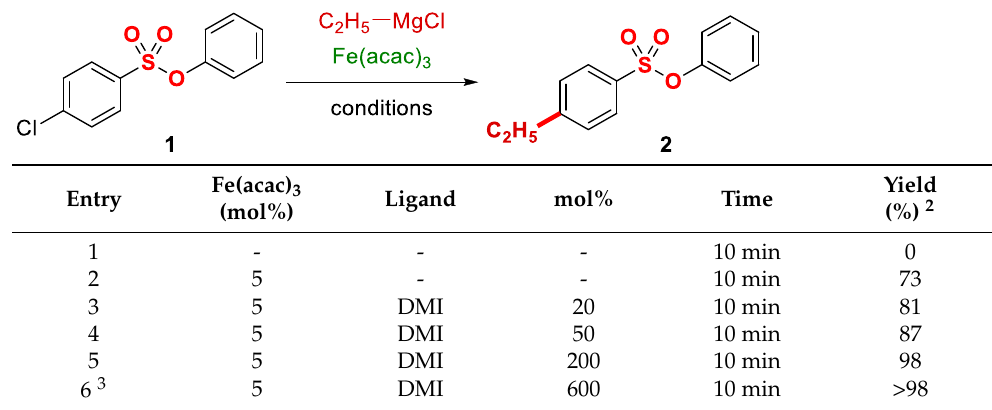
Table 1. Optimization of Fe-catalyzed cross-coupling 1 .